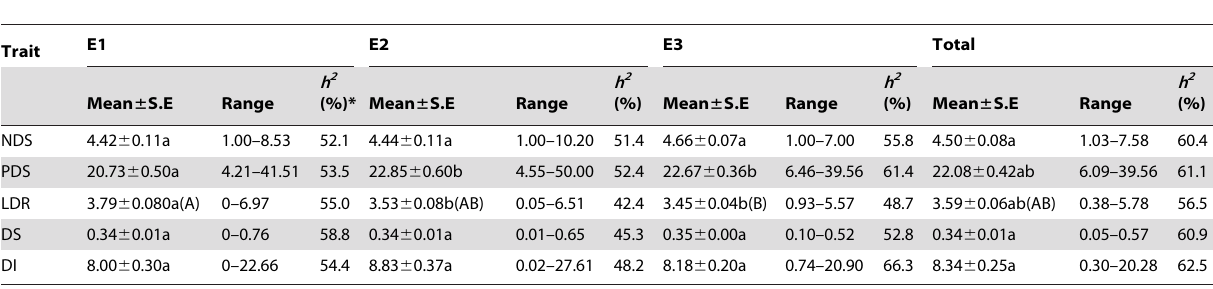
Table 1. Comparisons of five FHB-related traits in three environments.